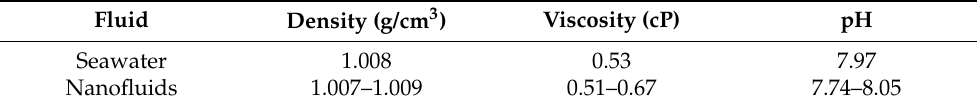
Table 2. Fluid properties measured at 60 ◦